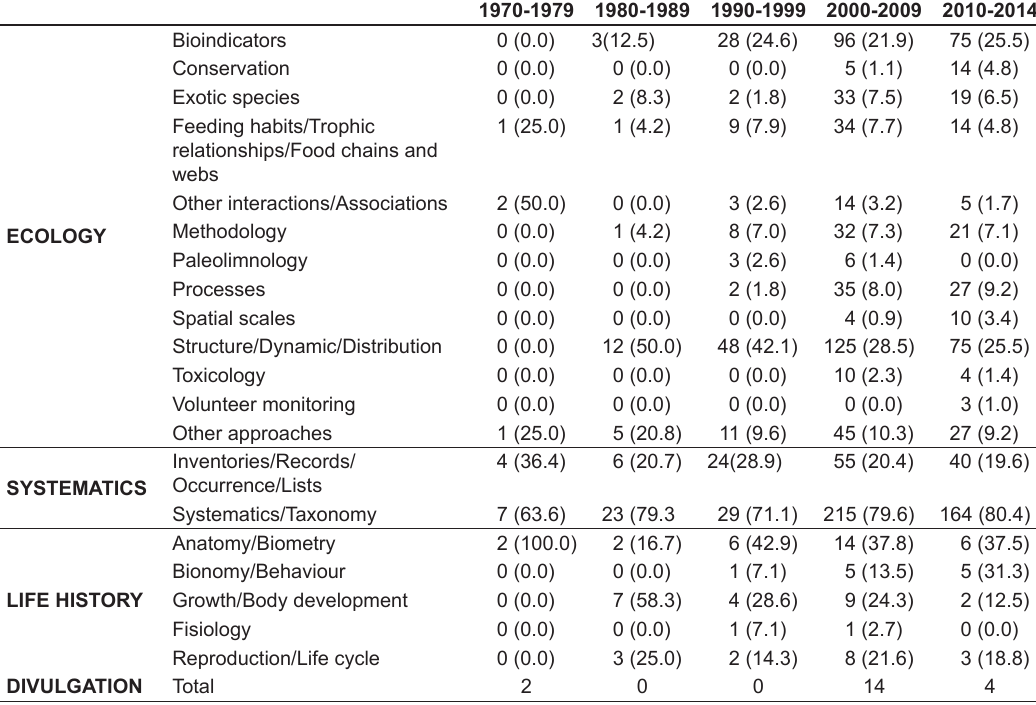
Table 2. Numbers and relative abundance (parentheses) of four broad categories of papers concerning Brazilian benthic invertebrates from 1970 to